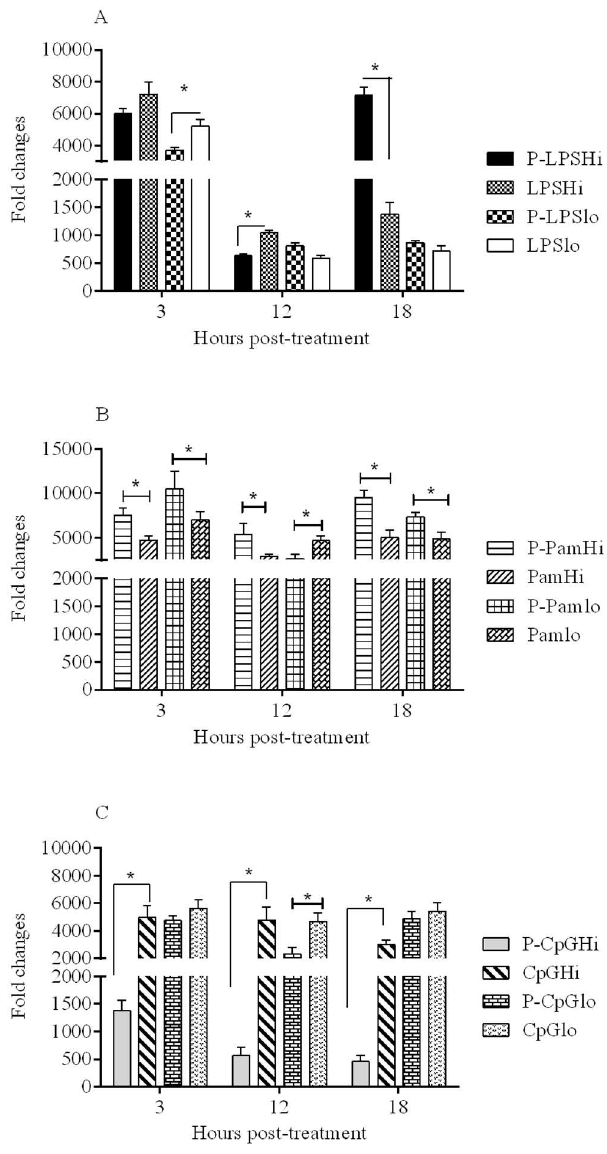
Fig 4. IL-1 β mRNA expressionin chicken macrophages stimulated with (A). LPS; (B). Pam3CSK4; and (C) CpG ODN. Chickenmacrophages (six replicates/group) were treated with encapsulated and soluble forms of the three TLR ligandsand mean fold expression of IL-1 β in treated groups were comparedto the cell culture medium treated group. Significance ( P < 0.05) was tested betweendelivery systems within a dose and at a given time point. *